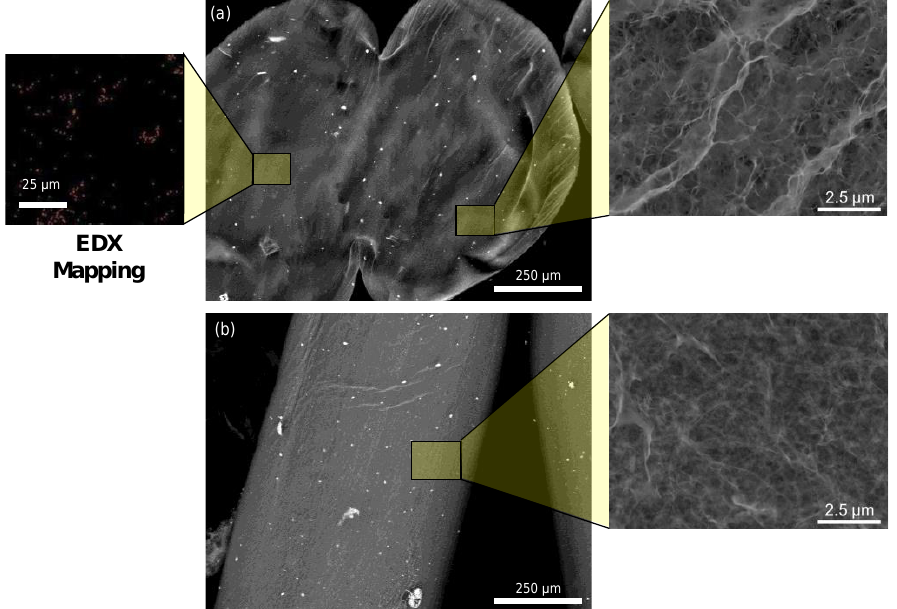
Figure 1. FESEM images of the chitosan–limonite fibers containing 10% limonite: ( a ) cross-section (inset shows the EDX elemental mapping of the fibers representing the distribution of Fe element) and ( b ) surface of the fibers viewed with an enlarged view inserted on the right.